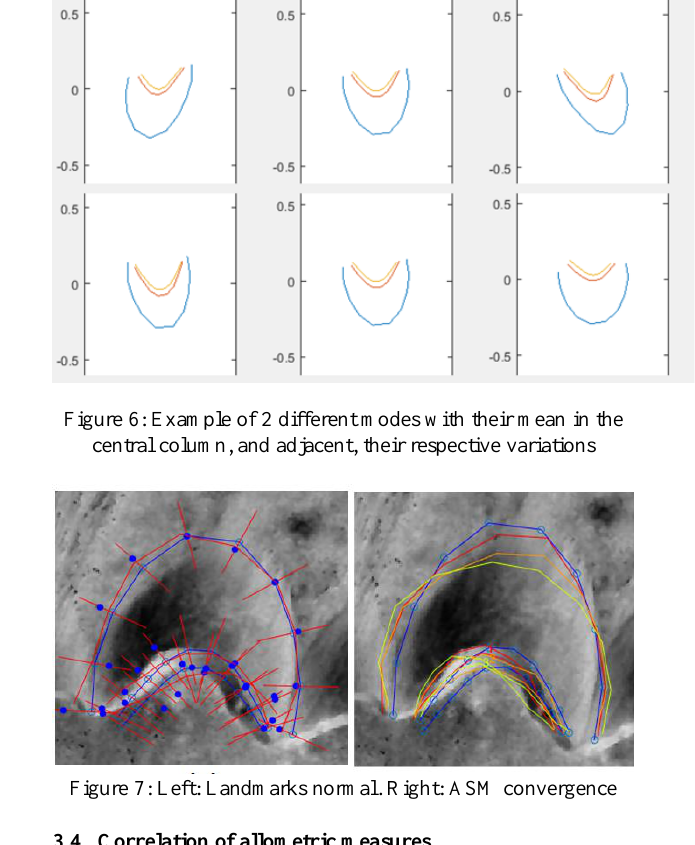
Figure 4: Example of cascade classifier detection 3.3 Active shape model fitting: